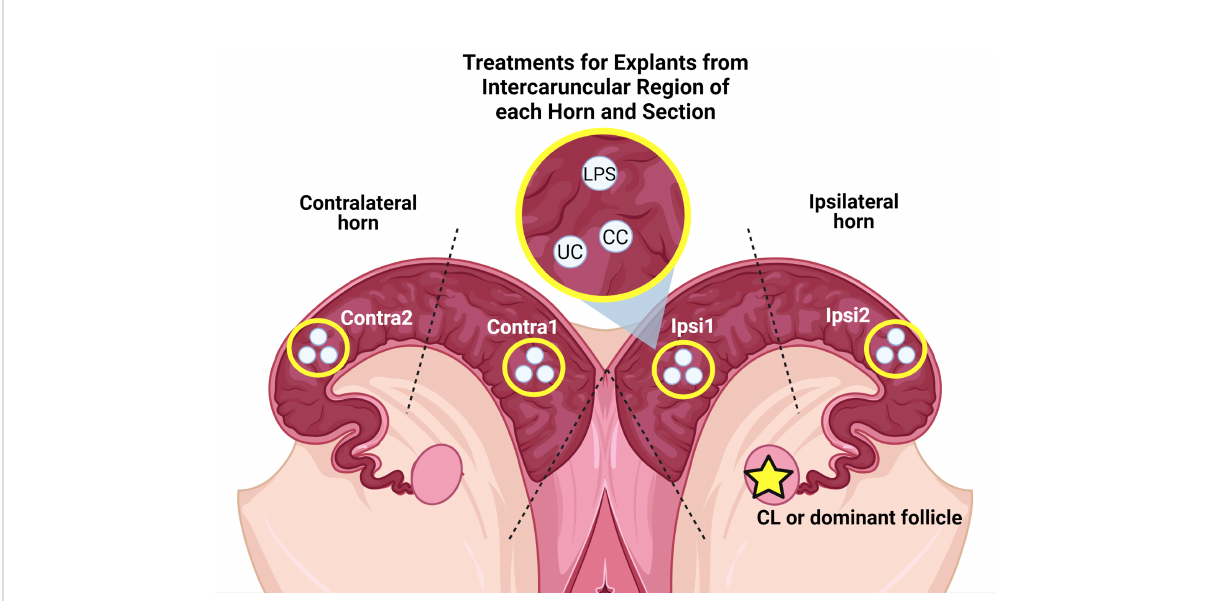
FIGURE 2 Sections of uterine horns with collected explants from the intercaruncular regions and their respective treatments. LPS: Cultured with complete media + LPS. CC: Control cultured in complete media without LPS. UC: Uncultured